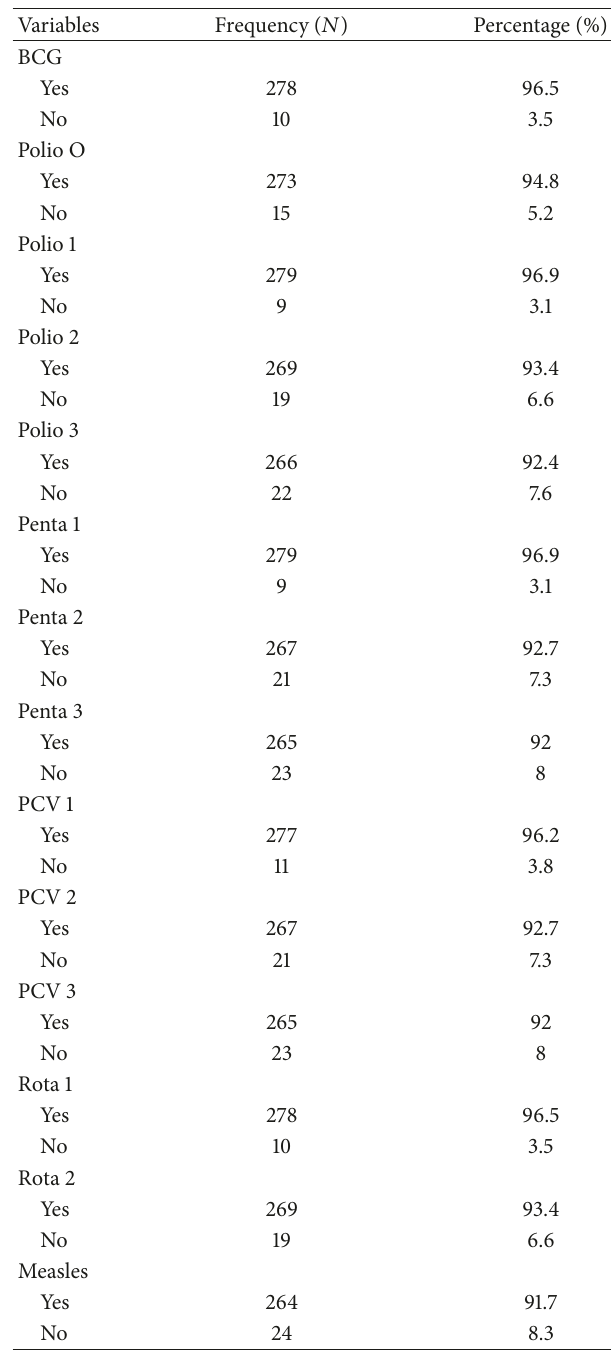
Table 4: Type of vaccines received by children aged 12–23 months in Debre Markos town, Amhara Regional State, North West Ethiopia, September 2016. ( 𝑁 = 288